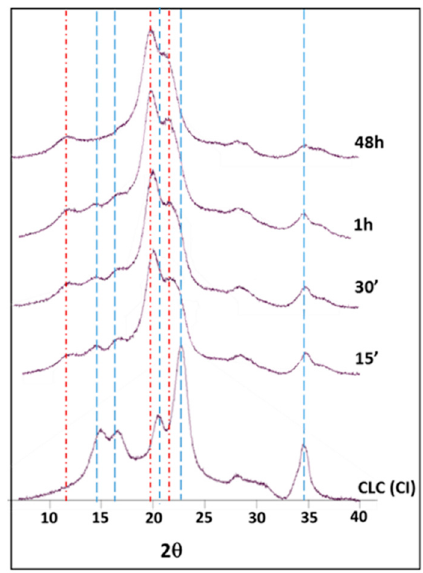
Figure 4. PXRD profiles of CLC at different mercerization times with constant NaOH concentration. Top trace is the reference for complete mercerization (see text). For clarity, the main peaks of CI [(1–10), (110), (102), (020) and (004)] and CII [(1–10), (110) and (020)] are indicated with blue and red lines, respectively.